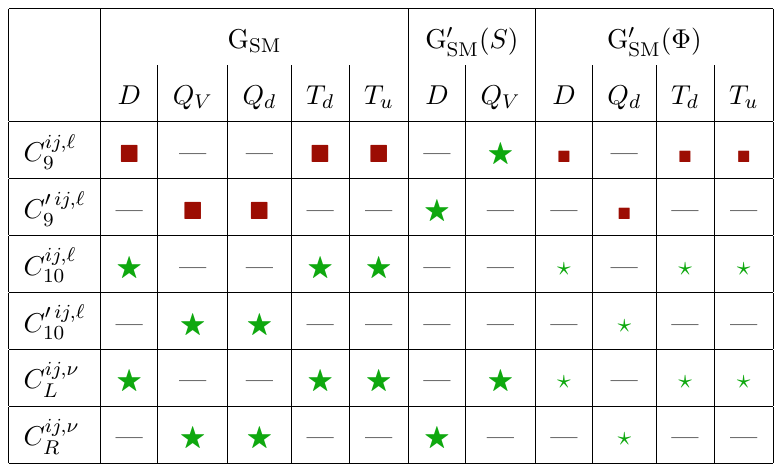
Table 6. \DNA" table for NP contributions to the b the d j d i (cid:23) (cid:22) (cid:23) ones C (cid:23) . F means that the NP contribution is potentially large, while (cid:4) stands L;R ! for a generically small contribution, due to the suppressed vector couplings of the Z to leptons compared to its axial-vector couplings. Smaller symbols in the G 0